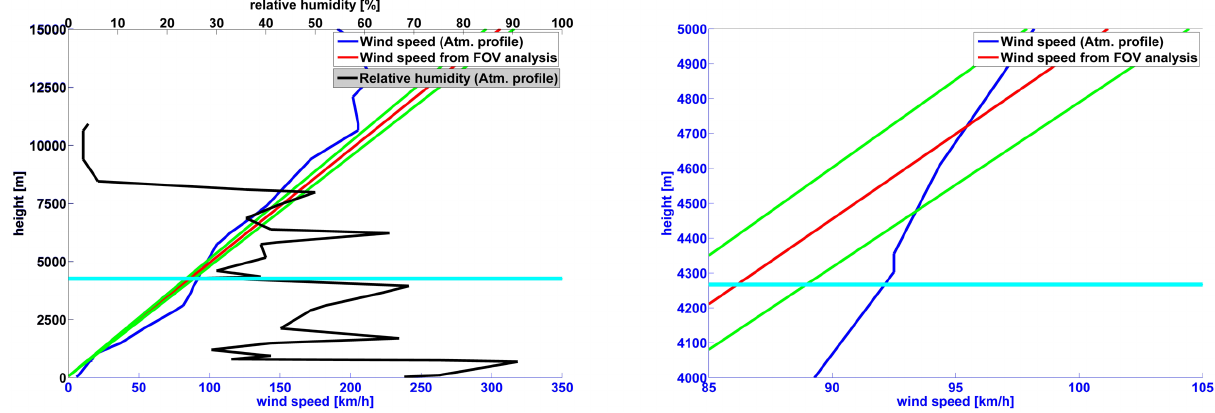
Fig. 14. Left: crossing measured wind velocity (blue line) with hypothesized possible wind velocities from FOV analysis (red line with green error lines). Right: zooming in on the 4720m crossing point. The cyan line is the cloud base height (4267m) extracted by a nearby ceilometer (Website: “Station